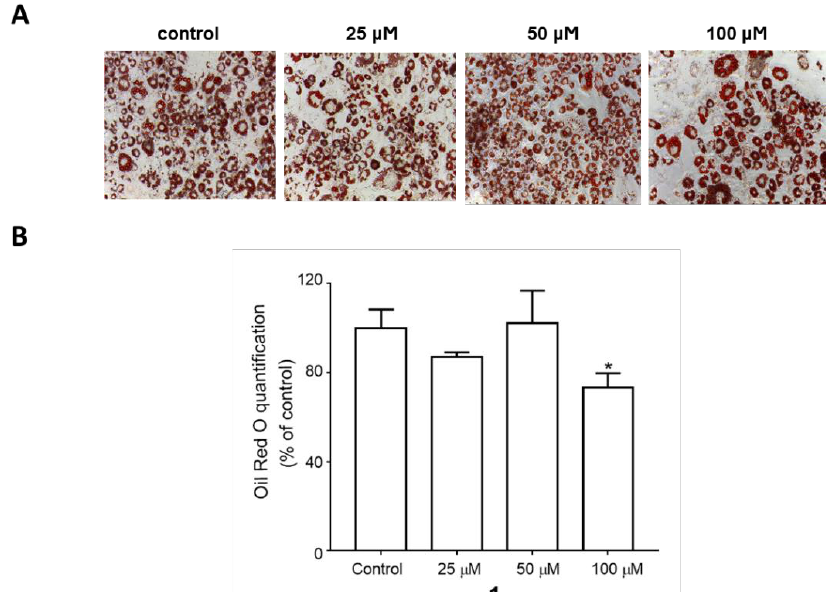
Figure 3. The inhibitory effect of compound 1 on lipid accumulation during adipocyte differentiation. 3T3-L1 preadipocytes were treated with various concentrations of compound 1 from the start of adipocyte differentiation (day 0) until day 4. ( A ) The representative Oil Red O staining pictures of differentiated adipocytes on day 8. ( B ) Quantification of Oil Red O staining. The values are the means ± SEM of three experiments. * p < 0.05 vs. control.